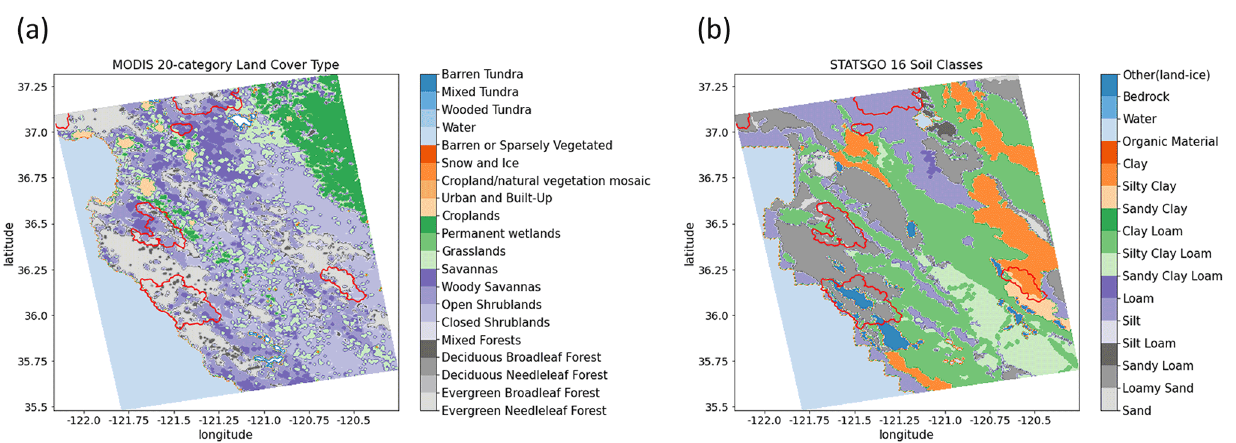
Figure B4. (a) MODIS IGBP 20-category land cover type in the model domain, (b) 1km STATSGO data with 16 soil texture types. The 2020 wildfire burn scar perimeters are outlined in